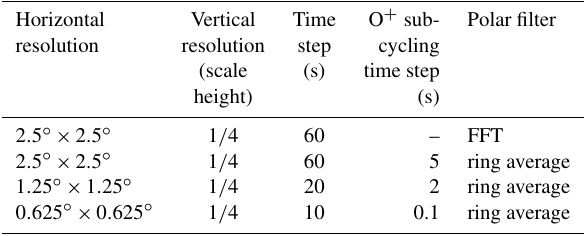
Table 3. Comparisons of horizontal resolution in a geographic latitude–longitude grid (column 1), vertical resolution (column 2), time step (column 3), O + sub-cycling time step (column 4), and polar filter (column 5) between different TIEGCM versions ∗